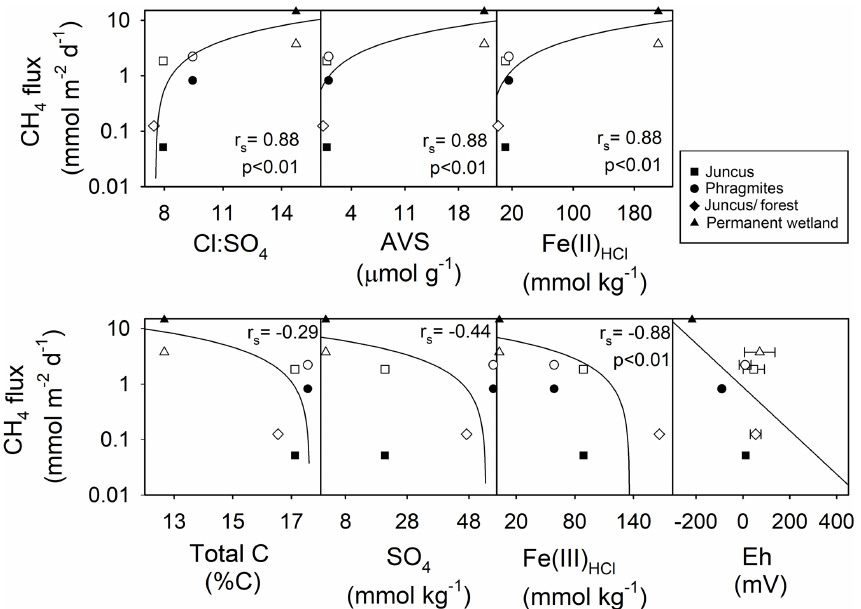
Figure 7. Regression analysis of average daily CH 4 fluxes (mmolm − 2 d − 1 ) vs. subsoil parameters of 0–20cm core depth (i.e. CH 4 “active” zone). Note: log scale y axis of CH 4 fluxes from the four wetland ecotypes over two campaigns. Note: the r s values calculated using Spearman rho are for C1 (black shapes) and C2 (white